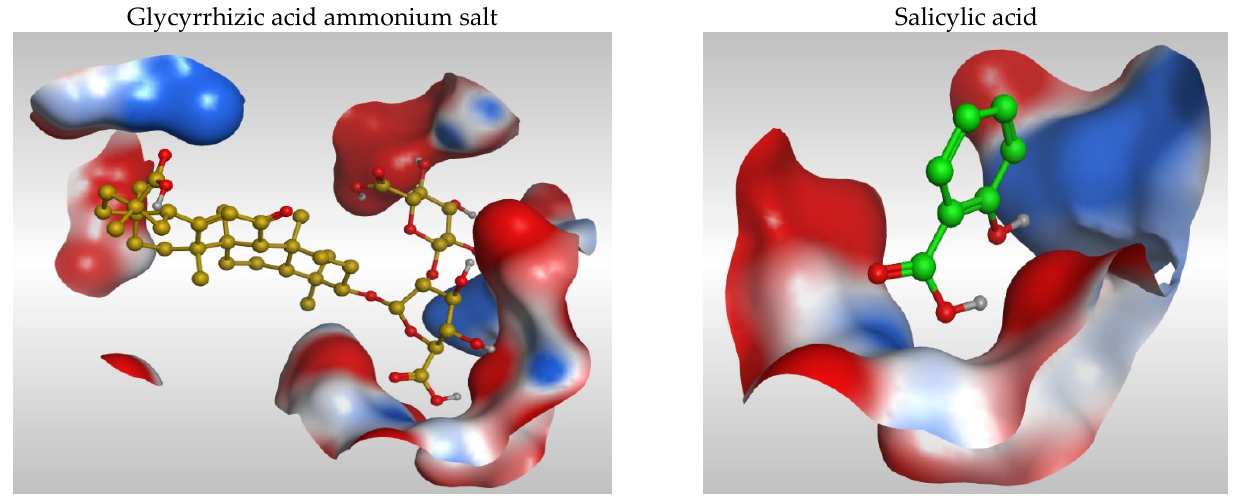
Figure 3. Surface and maps of our tested compounds, glycyrrhizic acid and salicylic acid, respectively, inside the central acidic patch of leaf roll viral protein coat.